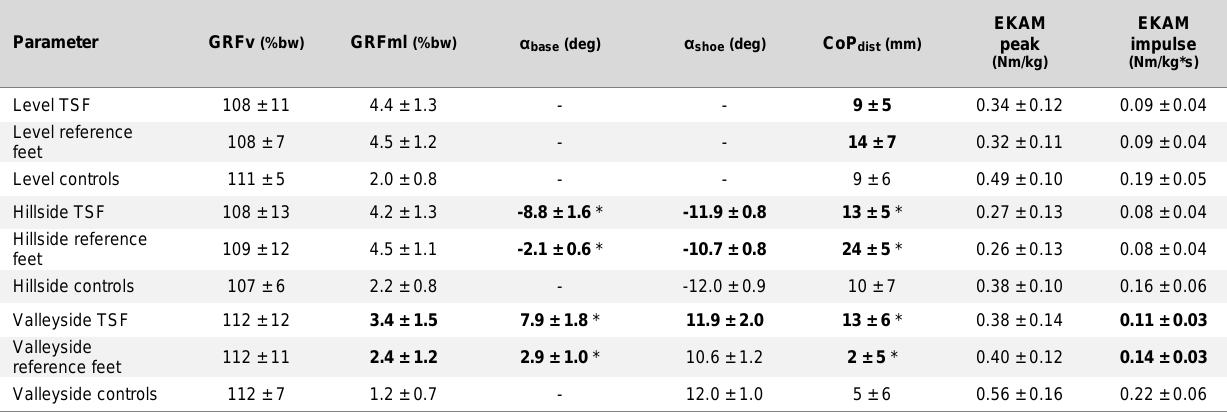
Table 3: Parameters of the prosthetic side for the different setups at the first maximum peak (GRFv, EKAM peak), whole GC (EKAM